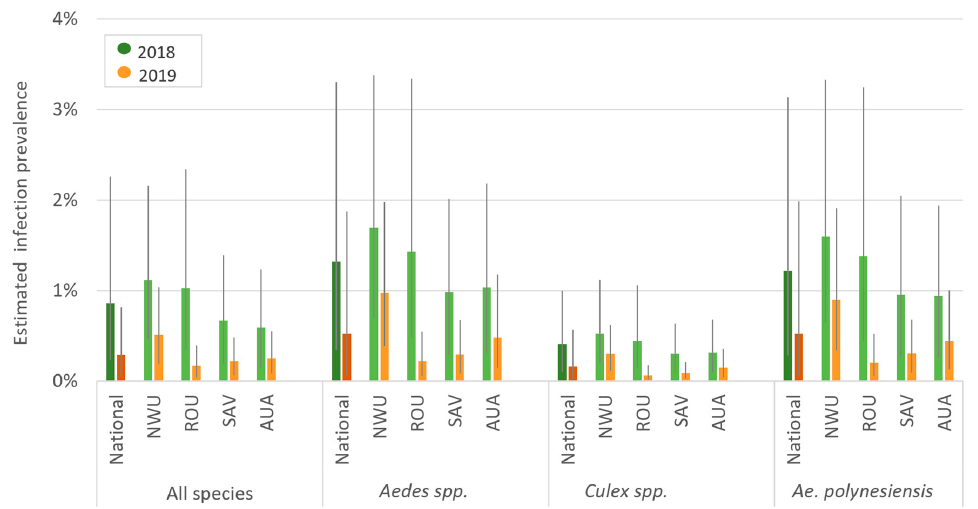
Figure 4. Estimated infection prevalence (%) by mosquito species, region and year (using data from the 28 randomly selected primary sampling units (PSUs) surveyed in both 2018 and 2019), Samoa. AUA = Apia Urban Area; NWU = North-West Upolu; ROU = Rest of Upolu; SAV = Savai’i. Values provided in Supplementary Table